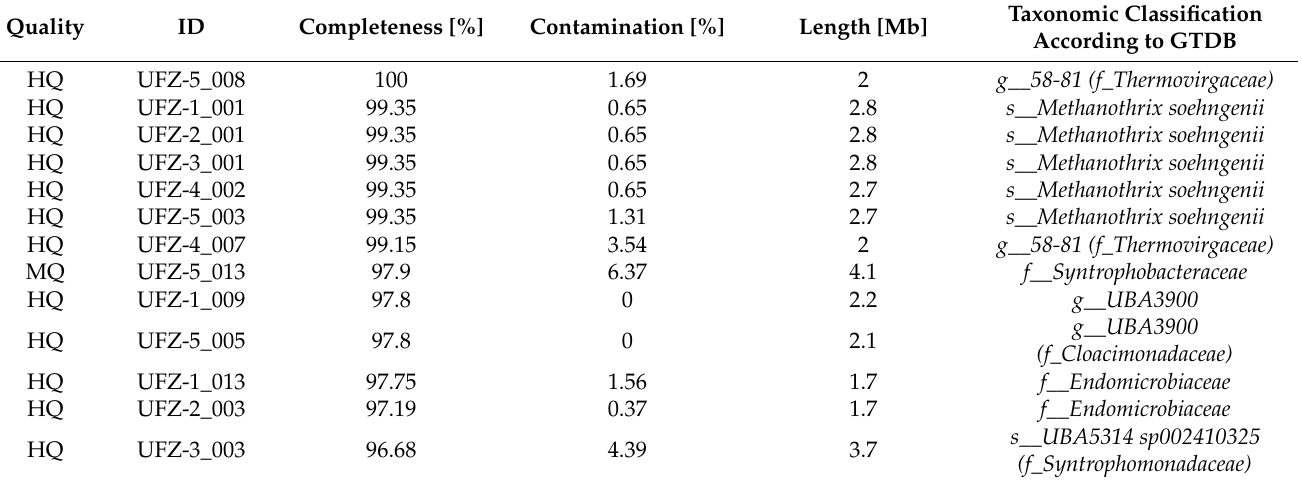
Table 2. Summary of Illumina-based MAGs after